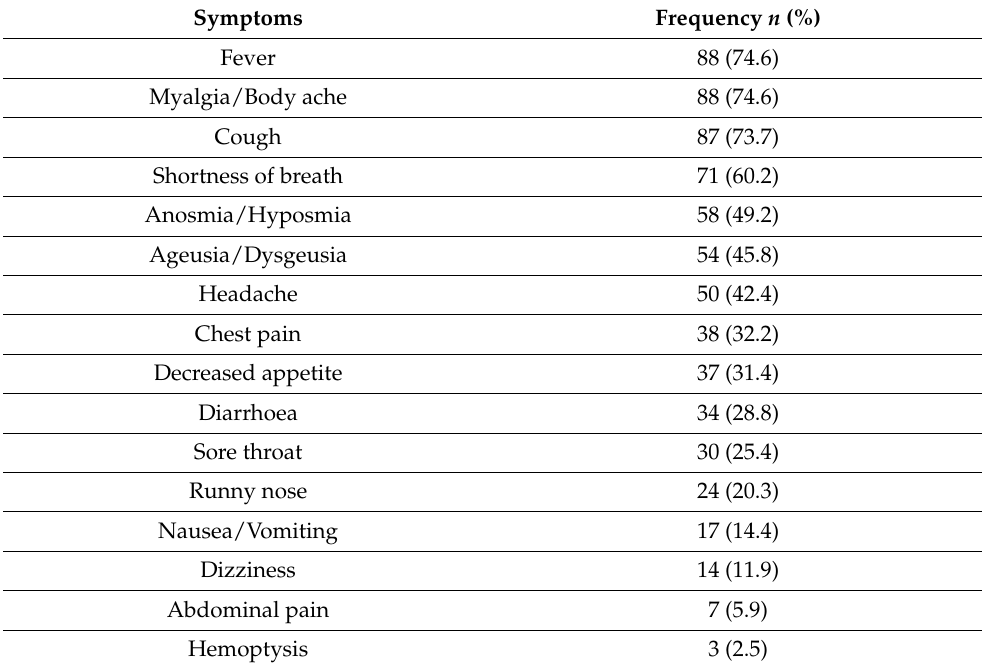
Table 2. Symptomatology during COVID-19 illness of post-COVID patients presenting to follow-up OPD at STIDH